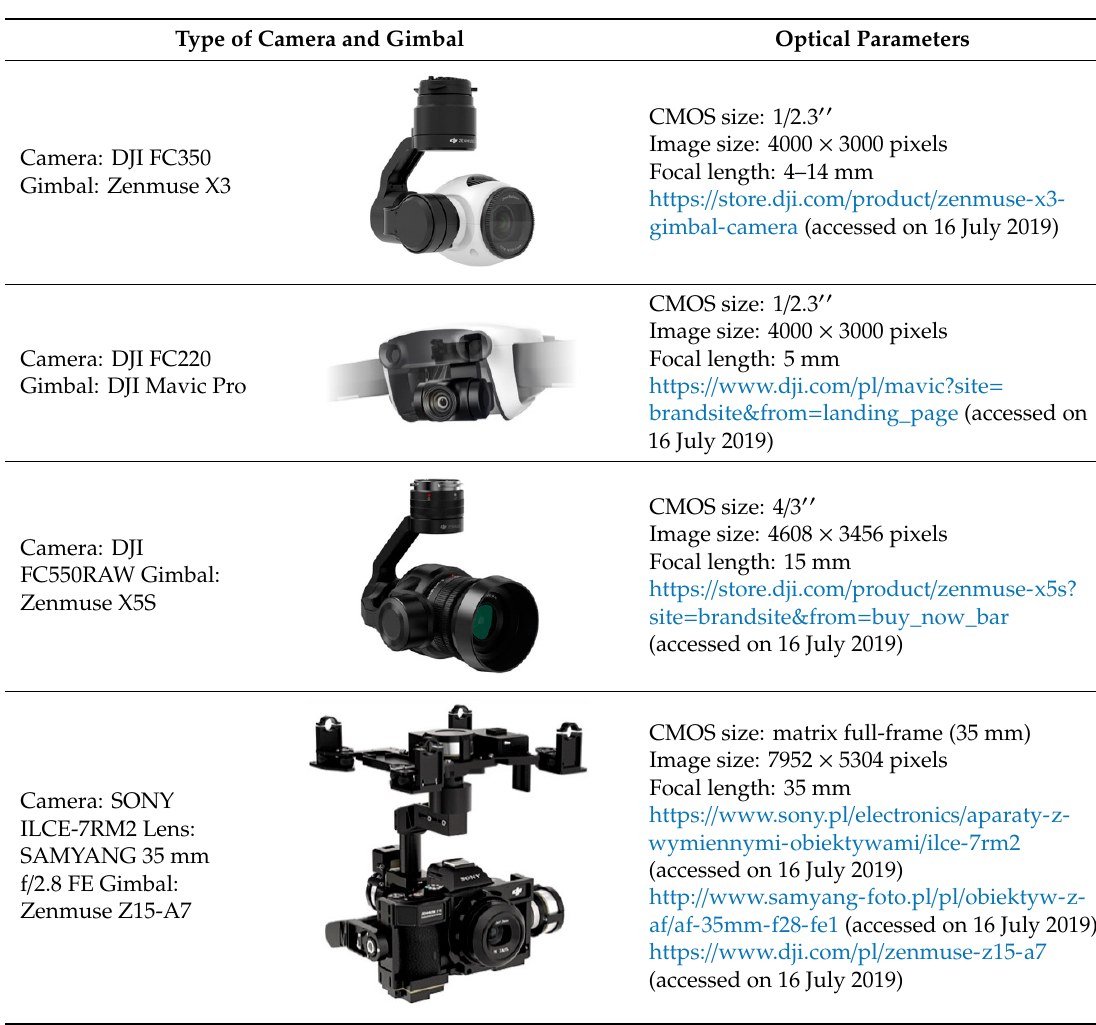
Table 1. Technical parameters of evaluated UAV cameras.